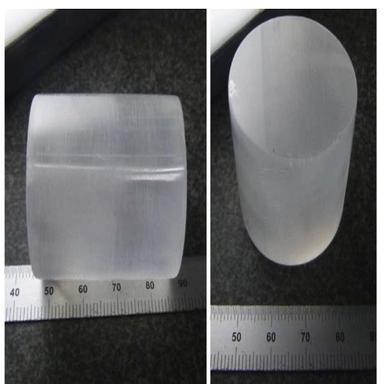
A ∅1.5″ × 2″ TLYC sample, lapped and polished at RMD, from a boule grown at Fisk.